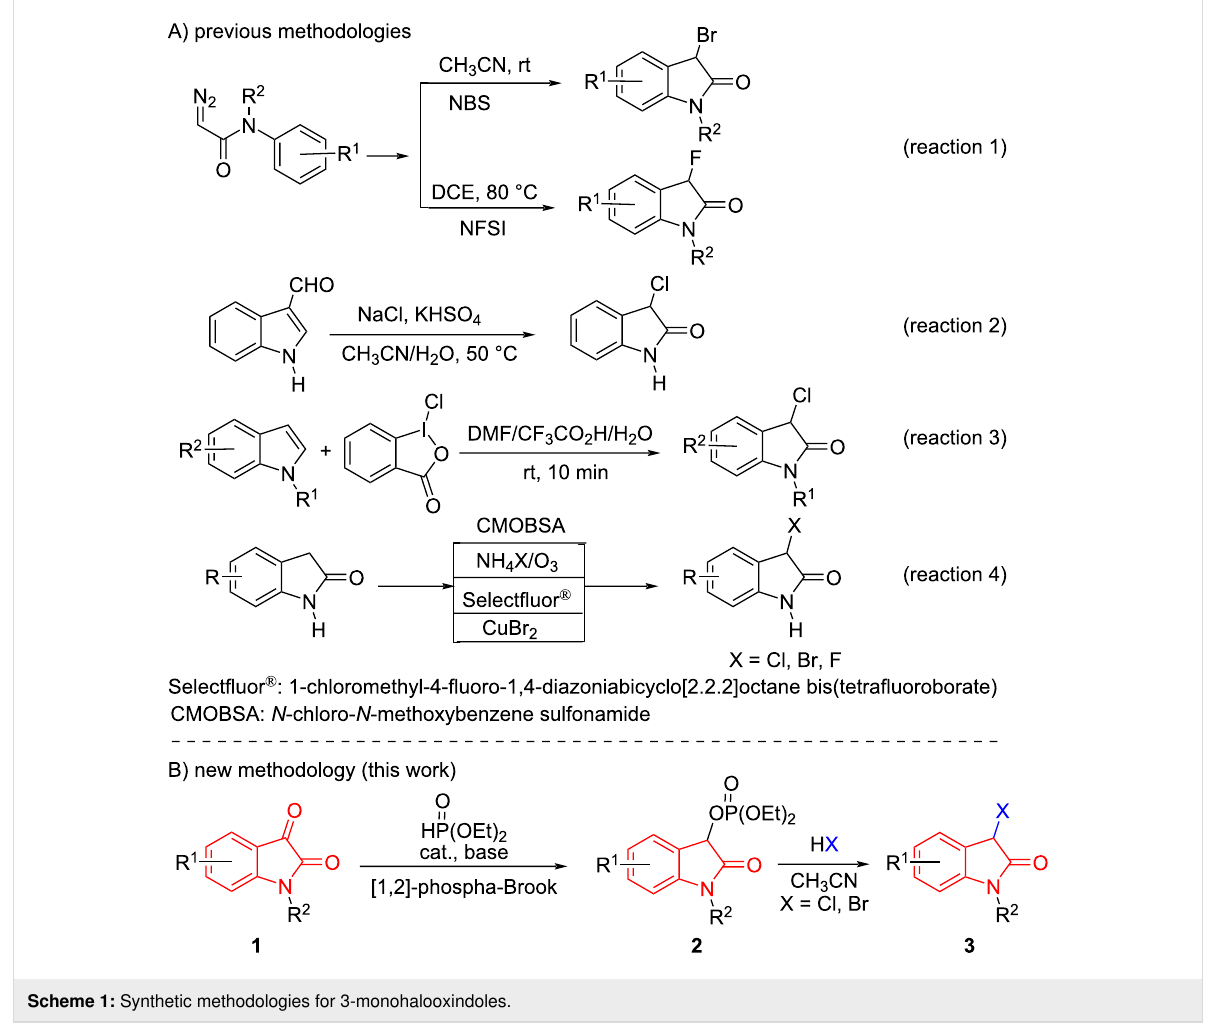
Scheme 1: Synthetic methodologies for